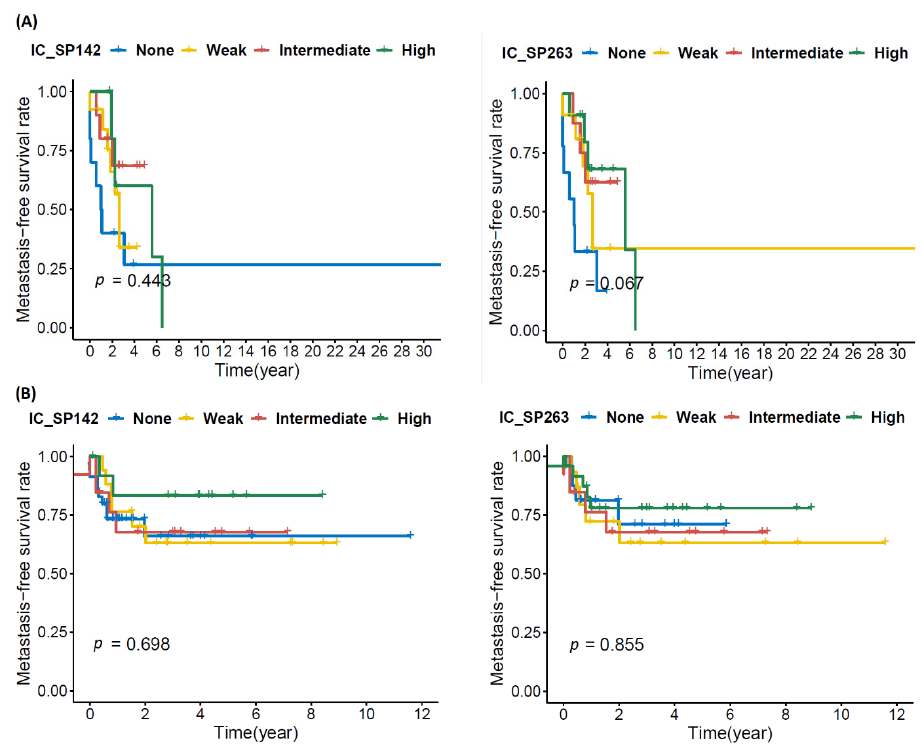
Figure A5. Kaplan–Meier curves depicting MFS based on PD-L1 immunoreactivity in immune cells for ( A ) liposarcoma and ( B ) undifferentiated pleomorphic sarcoma.